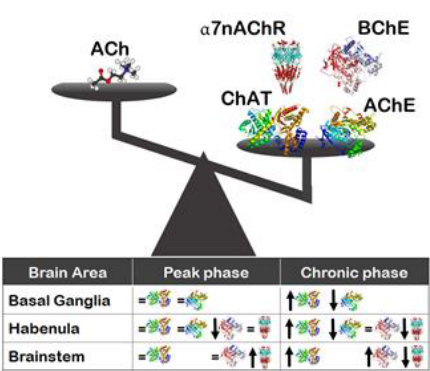
Figure 3. Cholinergic system changes in some brain areas (basal ganglia, habenula, and nuclei of the brainstem) of experimental autoimmune encephalomyelitis (EAE) mice at peak and chronic phases of the disease. ( A ) Photomicrographs showing AChE ( a ) and BChE ( c ) enzymatic activities stained histological brain sections and photomicrographs from autoradiograms of control mouse brain tissue sections visualizing brain areas expressing mRNAs coding for AChE ( b ), ChAT ( d ) and α7nAChR ( e ). ( B ) Representation of the homeostatic balance of cholinergic markers expression in brain areas of EAE mice. The table summarizes the quantification of enzymatic activities and mRNAs expression of cholinergic markers at peak and chronic phases of the disease. Abbreviations and symbols: CPu, caudate-putamen; CC, cerebral cortex; fi, fimbria; GP, globus pallidus; Hb, habenula; Hp, hippocampus; , ACh; , AChE; , BChE, ChAT; , α7nAChR.